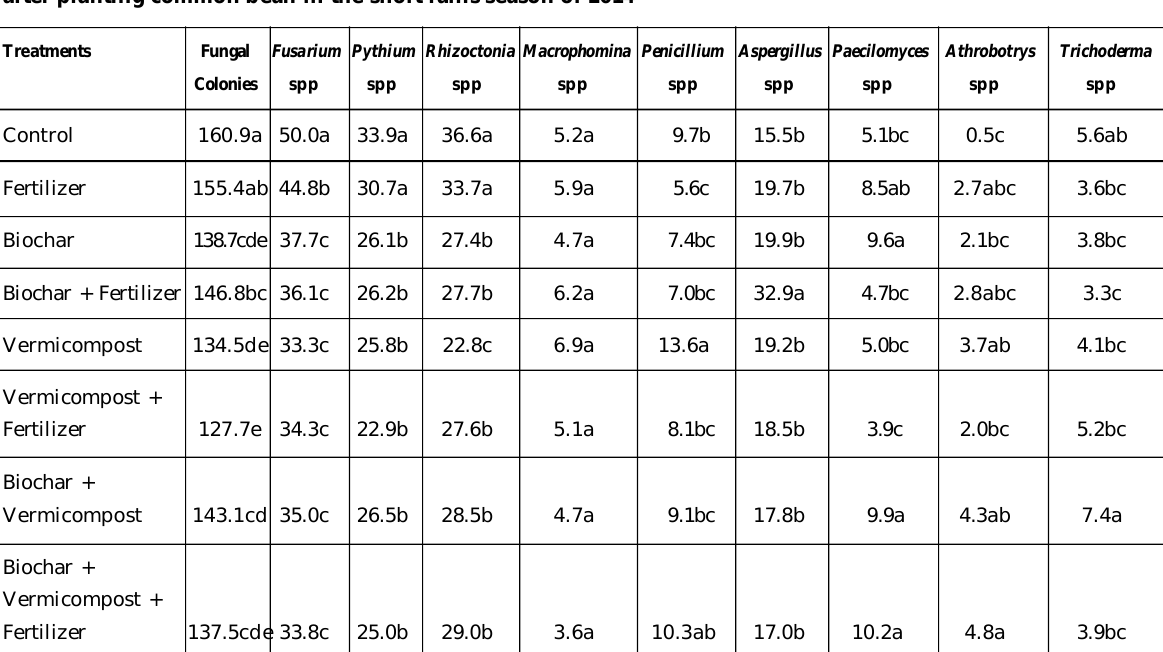
Table 13: The residual effect of biochar and vermicompost on fungal populations ( × 10 3 CFU/g soil) six weeks after planting common bean in the short rains season of 2014